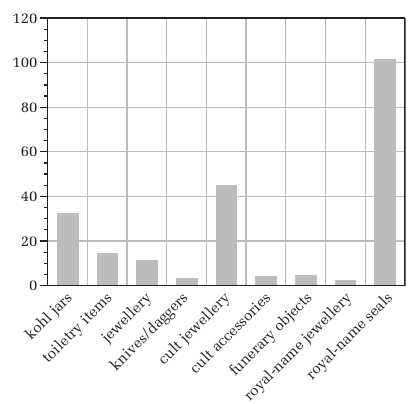
Figure 2 The frequency of selected classes of Egyptian material found at Tell el-’Ajjul, dating to the Middle and Late Bronze Age. Toiletry items include mir- rors, cosmetic applicators and razors; jew- ellery consists of amulets, and finger rings bearing divine names; cult accessories consist of figurines and musical instru- ments; funerary objects include shabtis (human figures) and fragments of canopic jars.